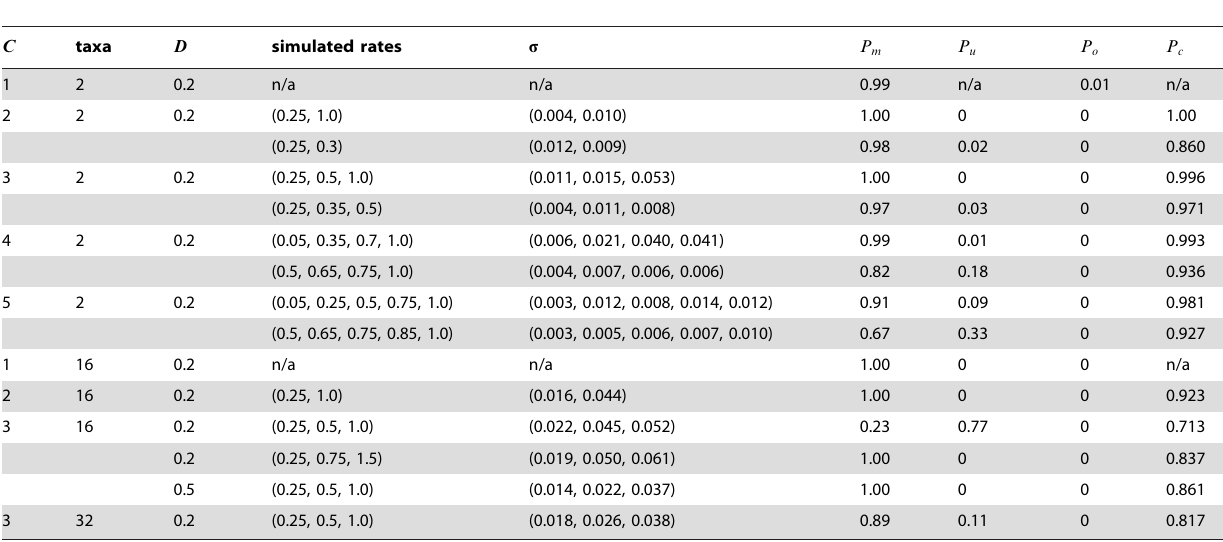
Table 2. The performance of GA model selection with mBIC in estimating the number and membership of K rate classes as well as rate values from simulated